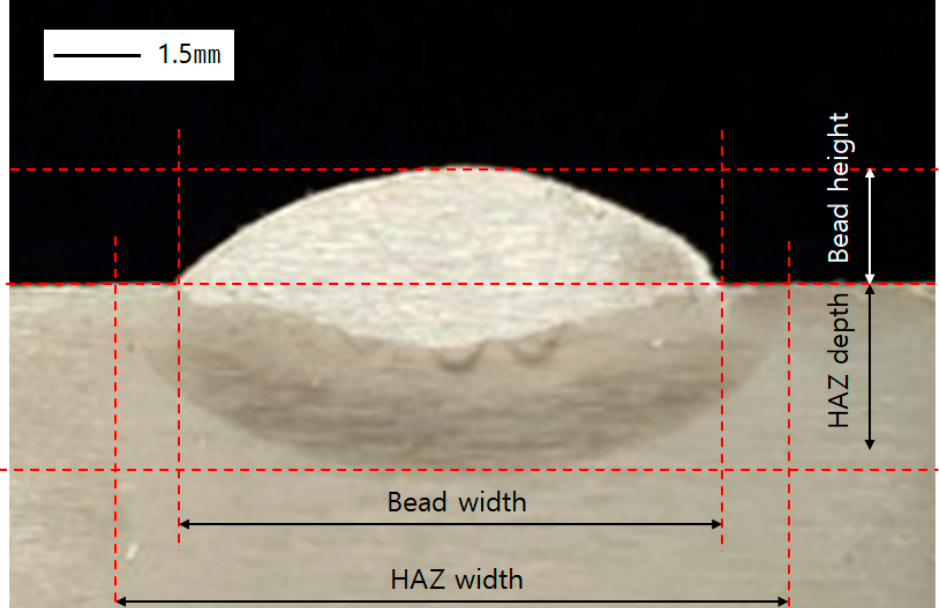
Figure 4. Optical microscope